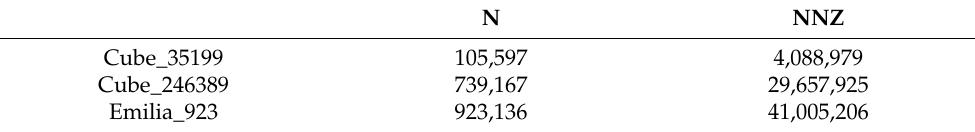
Table 9. Matrix datasets.